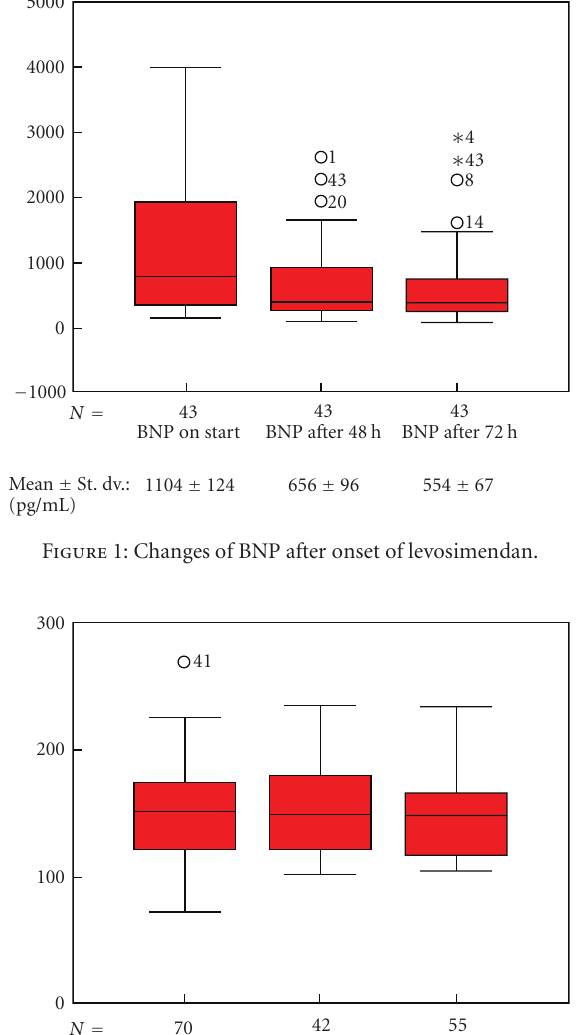
Table 1: Demographic statistics at baseline of the study population.